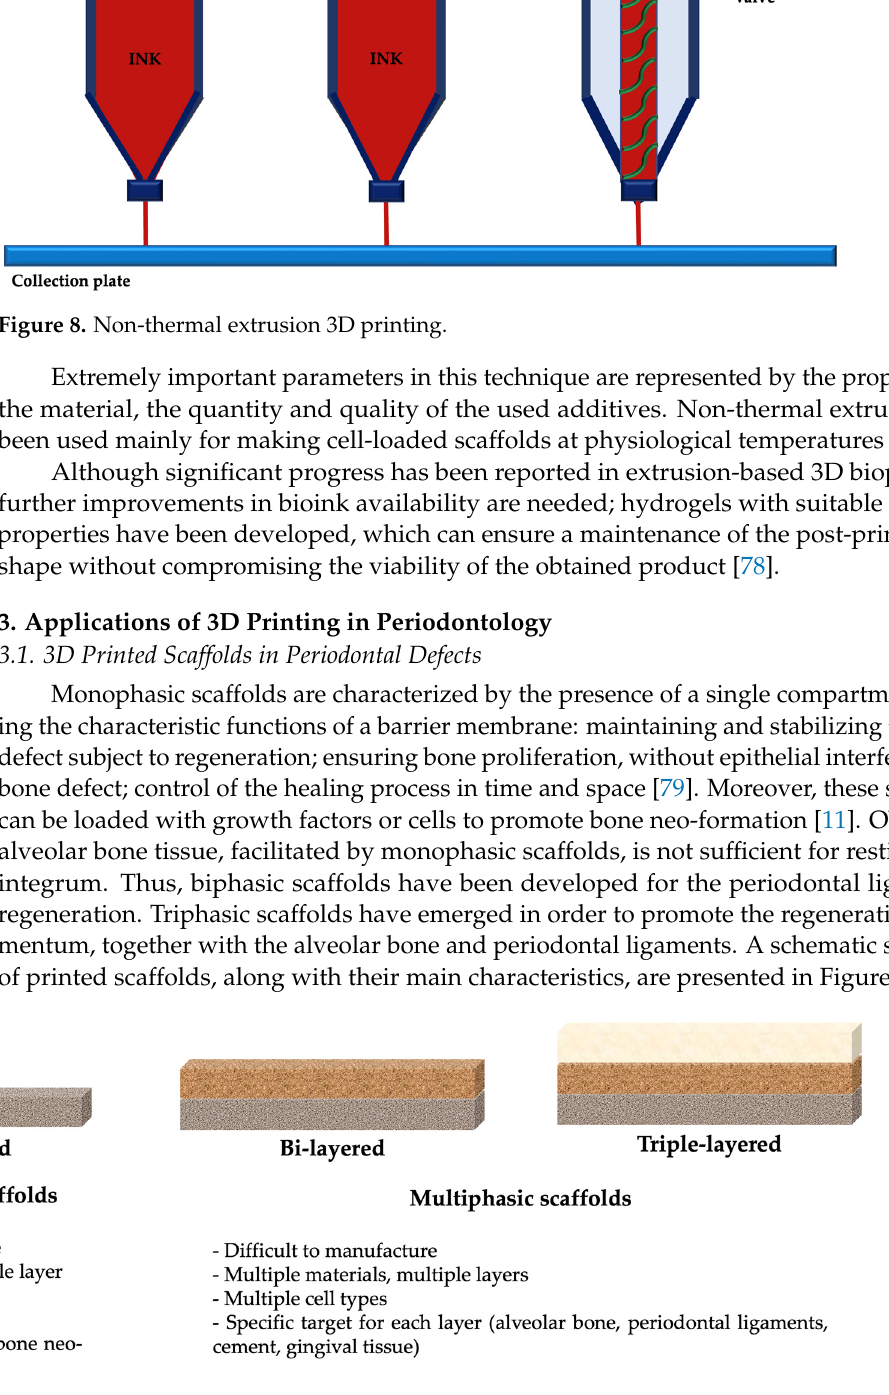
9 of 22 Figure 7. Thermal extrusion 3D printing: fused deposition modelling ( right ) and melt electrowrit- ting ( left ).